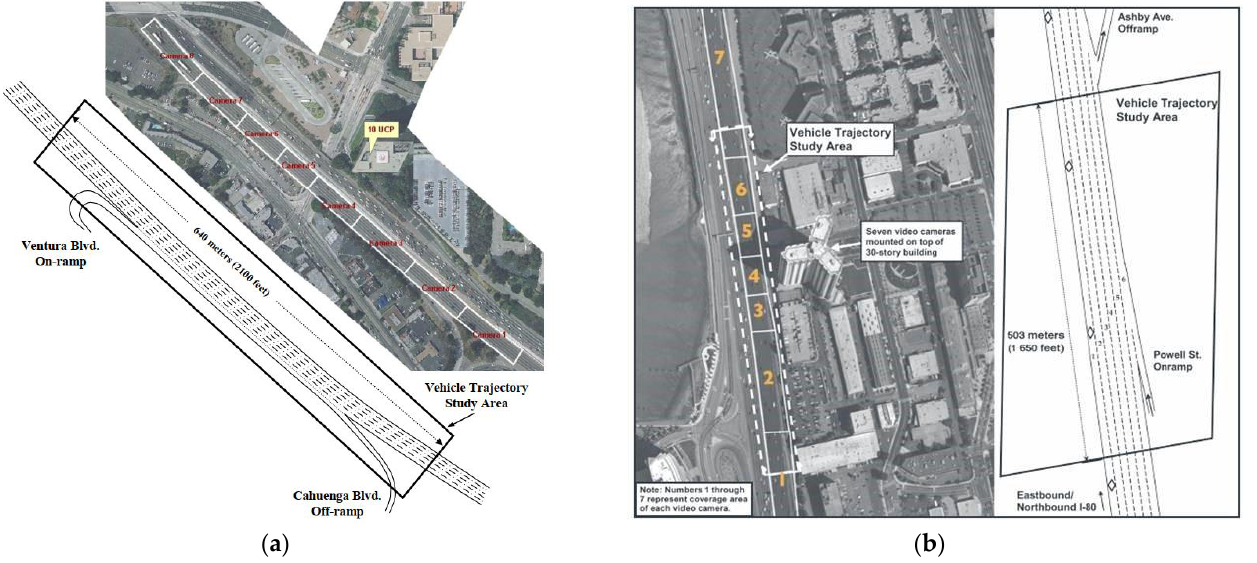
Figure 8. The extent of the NGSIM dataset study area. ( a ) The extent of the US101 dataset study area. ( b ) The extent of the I80 dataset study area.